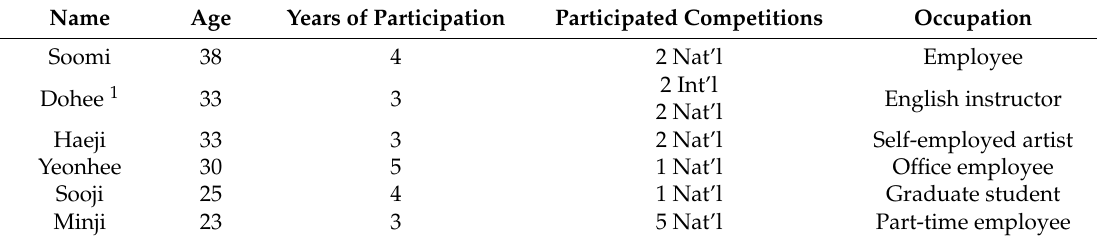
Table 1. Description of research